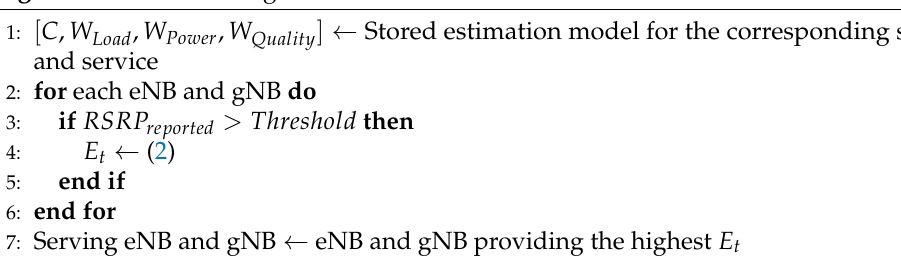
Figure 1. Block diagram of the proposed methodology. Algorithm 1 Node management